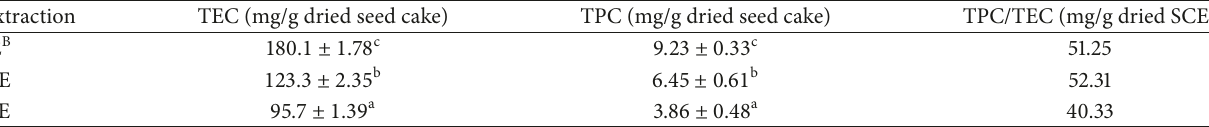
DE 40.33 A Assays were performed in triplicate. Mean ± SD values in the same column with different superscript letter are significantly different ( 𝑝 < 0.05 ); B IE